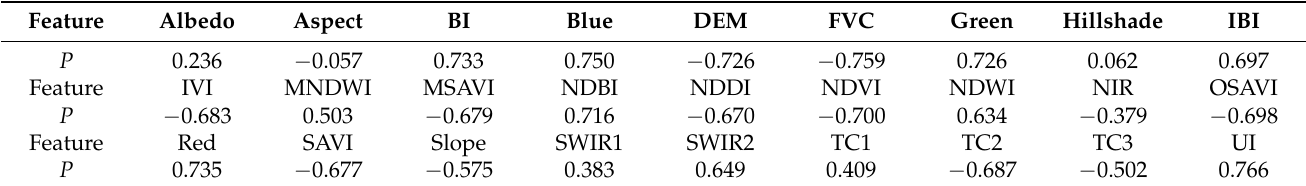
Table 5. Pearson correlation coefficients between features and